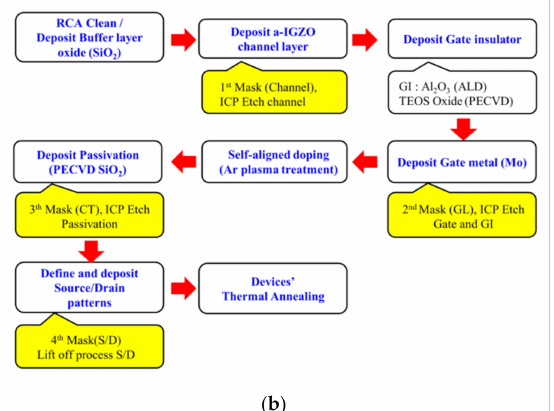
Figure 1. ( a ) Cross-sectional diagram of a top-gate amorphous indium gallium zinc oxide (a-IGZO) thin-film transistor (TFT) structure. (Source and drain-o ff sets = 1 µ m); ( b ) Process charts for each step of top-gate a-IGZO TFTs used in this